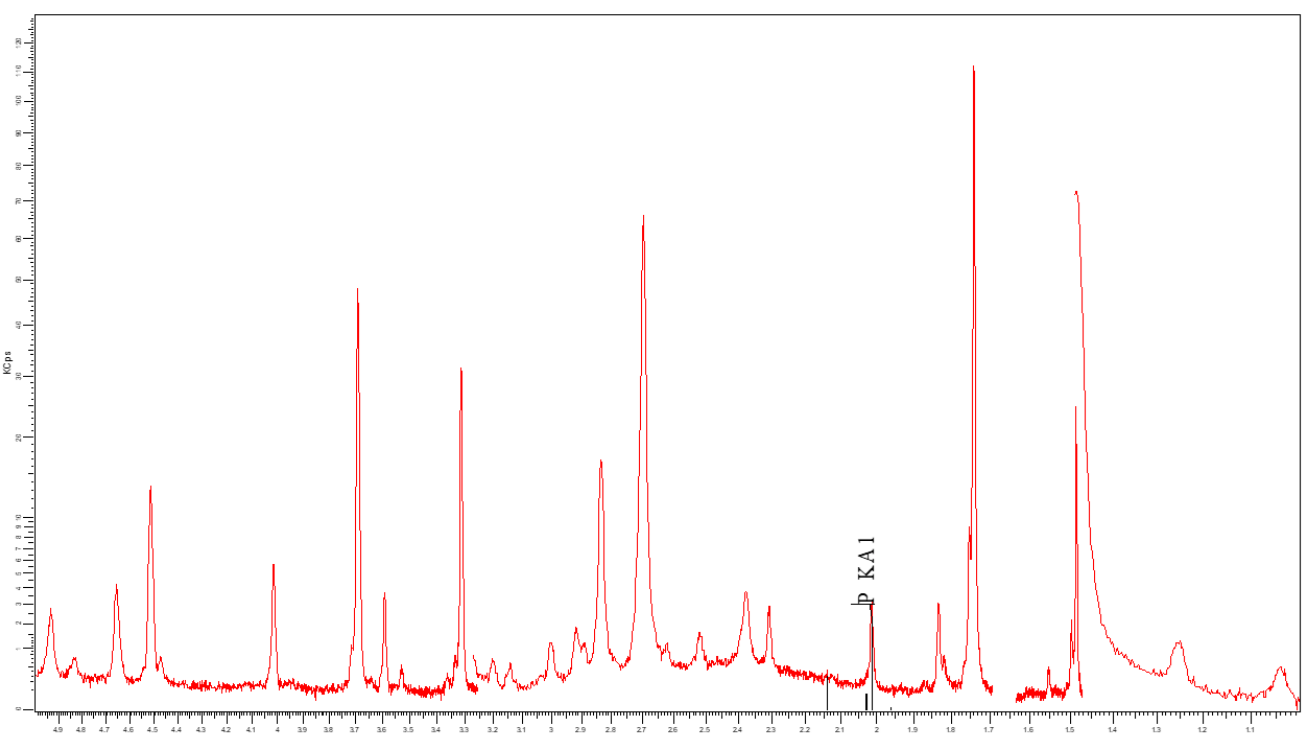
Figure 16. XRF analysis of fly ash pellets after adsorption.